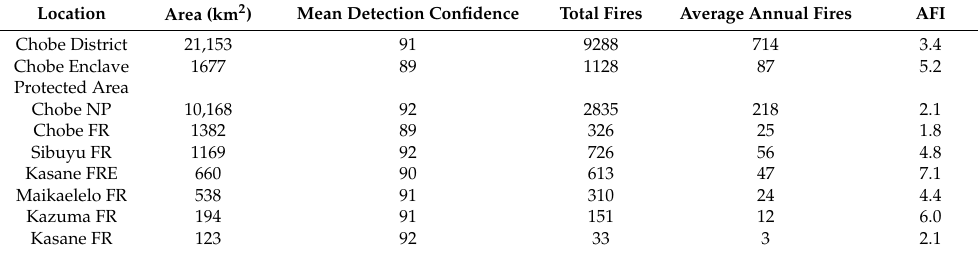
Figure 10. ( a ) MODIS fire detections for the Chobe District from 2001–2013 by month ( n = 9288, s = 1376) with long-term (1922–2013) average total monthly rainfall (mm) with standard deviations ( b ) total annual rainfall (mm) and active fires in the Chobe District from 2001–2013. ( c ) boxplots of woodland loss and fire frequency grouped by low ( ≤ 5), medium (6–14), and high ( ≥ 15) classes. Table 2. Summary of fire frequency for the Chobe District, Enclave, and protected areas. Mean detection confidence levels for each location are included, along with an area-weighted annual fire index (AFI), calculated by dividing average annual fire frequency by total land area (fires*year − 1 /km 2 ), representing a straightforward way of comparing fire incidence in analysis units of varying